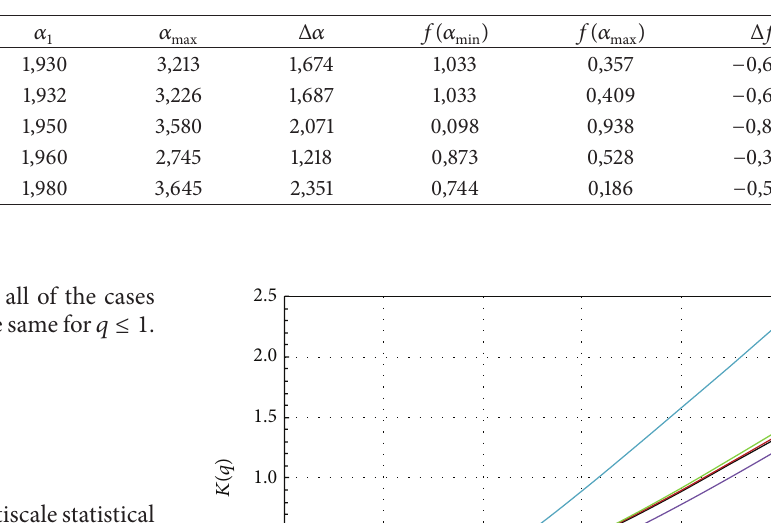
Table 2: Parameters extracted from the multifractal spectrum based on the average absolute differences of altitudes with the water reservoir at different filling levels. Holder exponent at 𝑞 = −5 (𝛼 max ), 𝑞 = 0 ( 𝛼 0 ), 𝑞 = 1 ( 𝛼 1 ), 𝑞 = +5 ( 𝛼 min ), and 𝛼 max − 𝛼 min ( Δ𝛼 ). Multifractal value at 𝛼